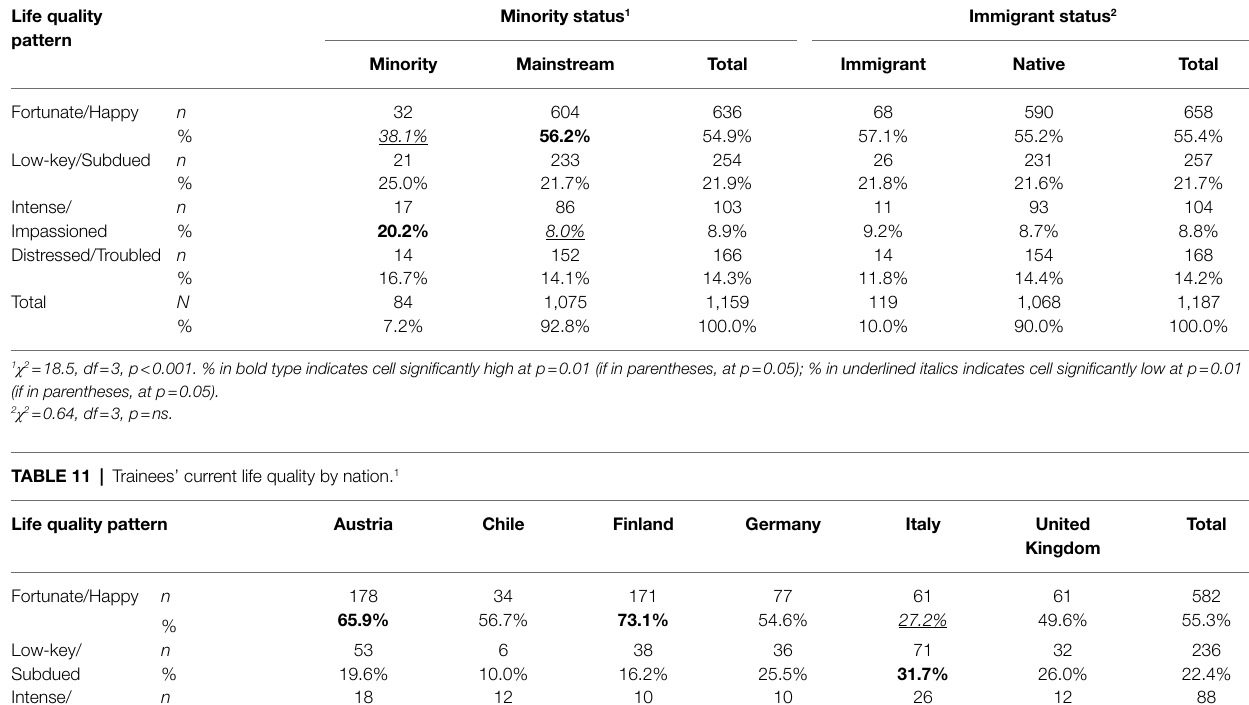
TABLE 10 | Trainees’ current life quality by social marginality. Life quality pattern